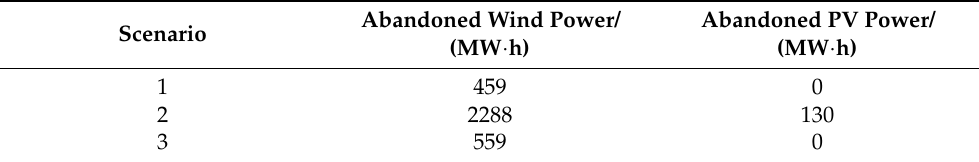
Figure 6. Output of each producer after secondary clearing. Table 3. Comparison of renewable energy consumption in different